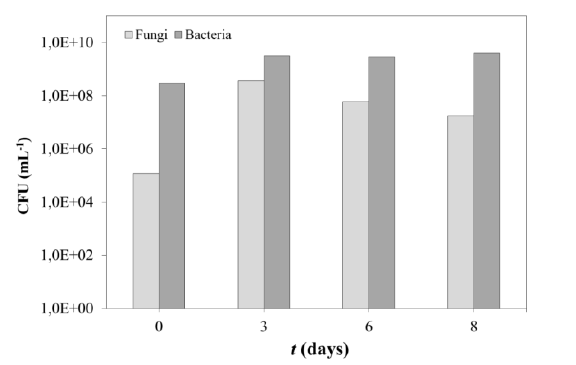
Figure 3. Changes in CFU for bacteria and